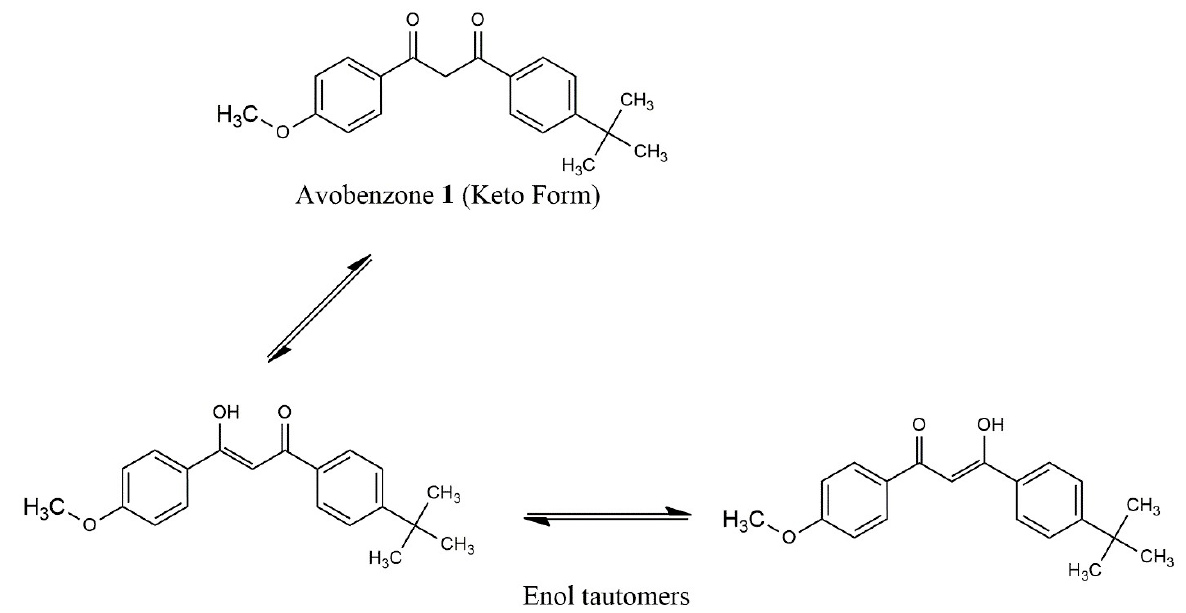
Figure 2. Structure and keto-enol tautomerism of avobenzone. Two bands are obtained. The enol form of AVOB produces a band at 355 nm, and the keto form of AVOB in cyclohexane produces a band at 265 nm. In more polar solvents, the enol band shifts to higher wavelengths: ethyl acetate = 356 nm, DMSO = 363 nm, and methanol = 358 nm.